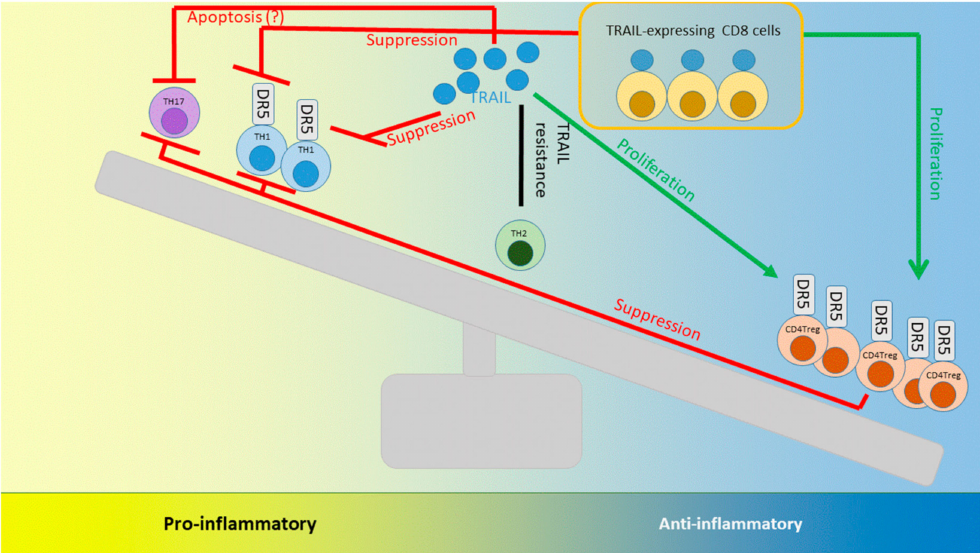
Figure 3. Interactions of TRAIL with T cells. While TRAIL inhibits the proliferation of Th1 cells, TRAIL expressed on dendritic cells has been shown to enhance the proliferation of CD4 regulatory cells [58]. Furthermore, a TRAIL-expressing population of CD8 cells exerting regulatory properties has been identified [56]. While Th2 cells were resistant to TRAIL-induced apoptosis in in vitro experiments, contradictory data exist in the literature for the regulation of TH17 cells